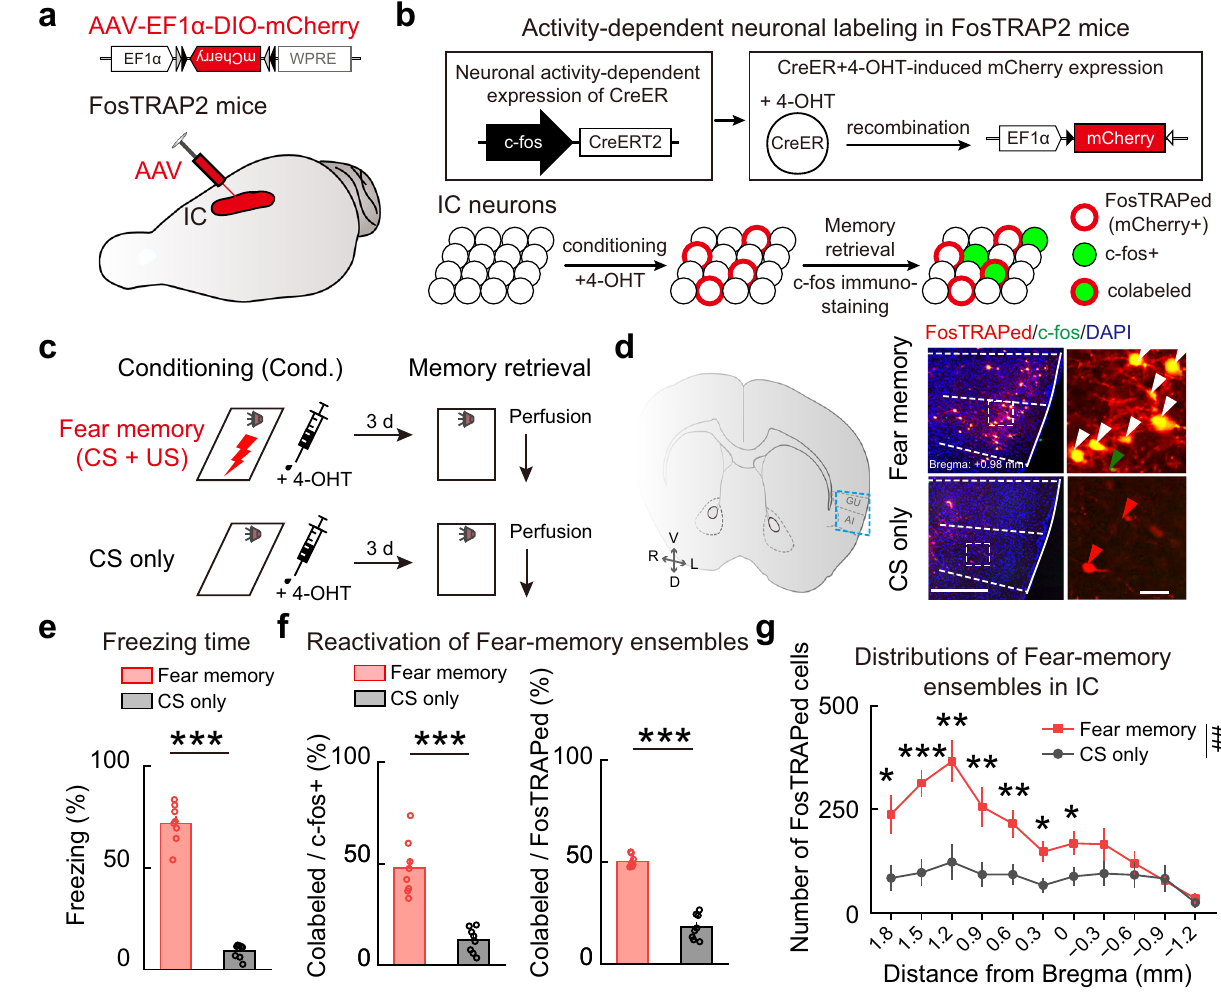
Fig. 1 | FosTRAPed fear-memory ensembles in IC. a Schematic of AAV injections toidentifymemoryensemblesinIC. b Experimentaldesign.Redcircles,FosTRAPed neuronsactivatedduringbehavioraltagging.Greencircles,immunostainingc-fos+ neurons activated during memory retrieval. Yellow circles, colabeled FosTRAPed and c-fos+ neurons. c – g Distribution patterns of activated IC neurons during fear learning and memory retrieval. Fear memory, n =8 mice; CS only, n =8 mice. c Schematic of behavioral protocols. d Example images of FosTRAPed (red) and c- fos+ (green) neurons in IC. Left: coronal diagram. Middle: enlarged view of the region in the blue dashedboxshowing IC. Right: enlarged view ofthe region inthe white-dashed box in IC. Red arrowhead, FosTRAPed only. Green arrowhead, c-fos+ only.Whitearrowhead,bothFosTRAPedandc-fos+.Red,FosTRAPed;green,c-fos+; blue, DAPI. Scale bars, ( left ) 500 μ m, ( right ) 50 μ m. e Freezing responses to the CS during the fear-memory retrieval session ( t (14) =17.49, *** P =6.5867E − 11, two-tailed unpaired Student ’ s t test). f Overlap rate of IC neurons activated during fear